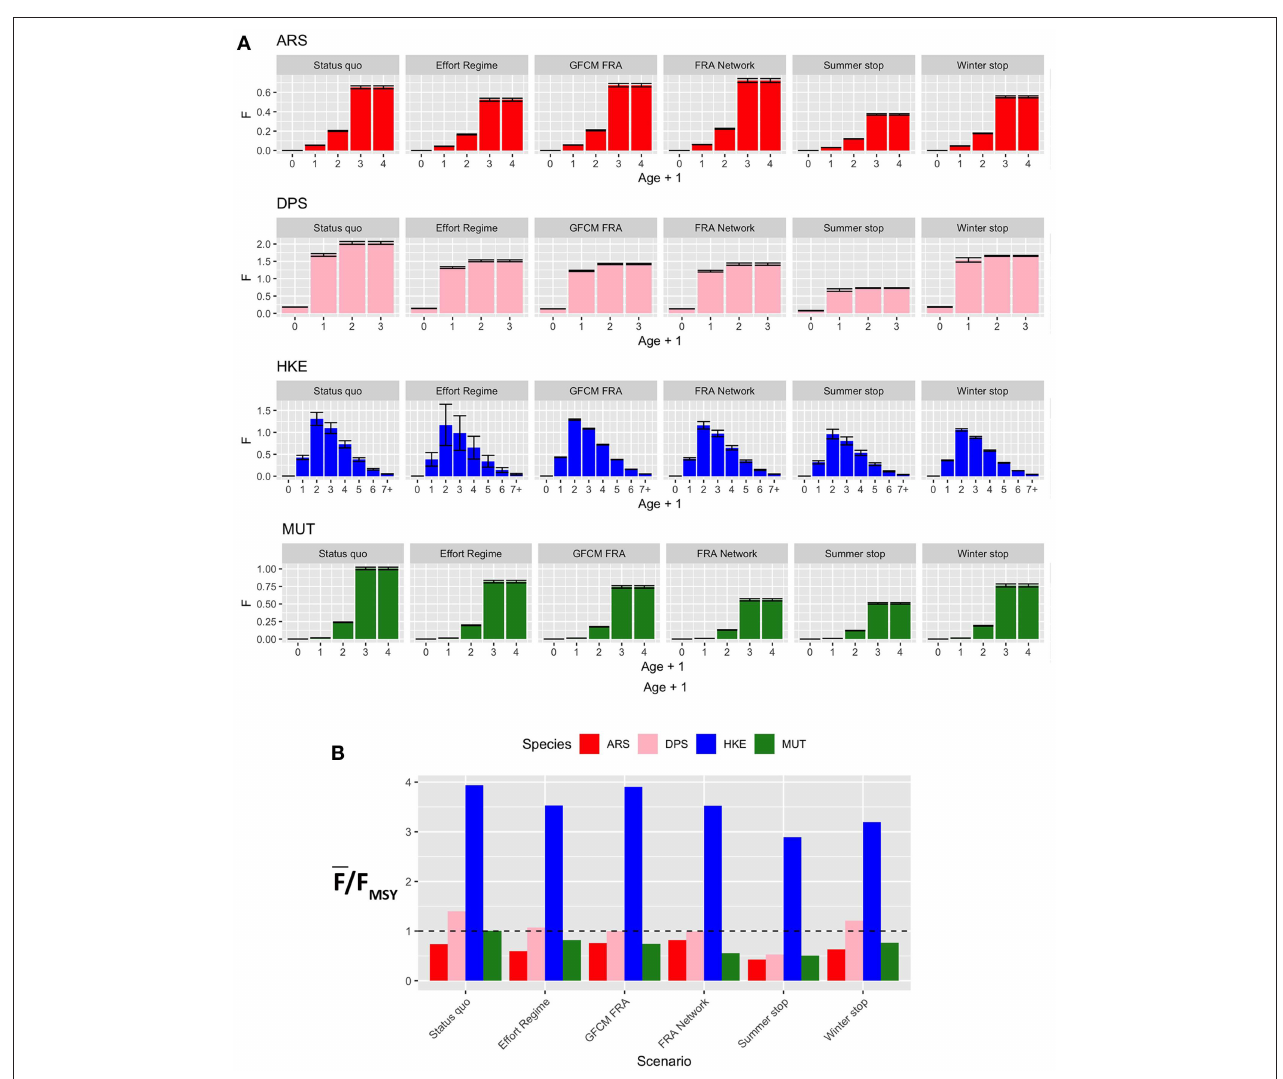
FIGURE 8 | Barplot (mean and MSE) representing (A) F at age for each species and scenario, corresponding to the new fishing effort pattern after the introduction of a different management measure; (B) the corresponding overexploitation rate ( F F ) for the different species and scenarios. Age ranges for the computation of F ¯ were MSY as follows: 1–3 years (ARS), 0–2 years (DPS), 1–5 years (HKE), and 1–3 years